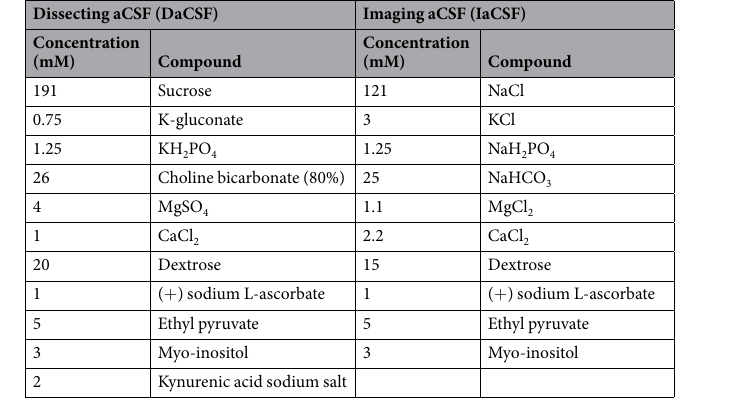
Table 1. Composition of aCSF